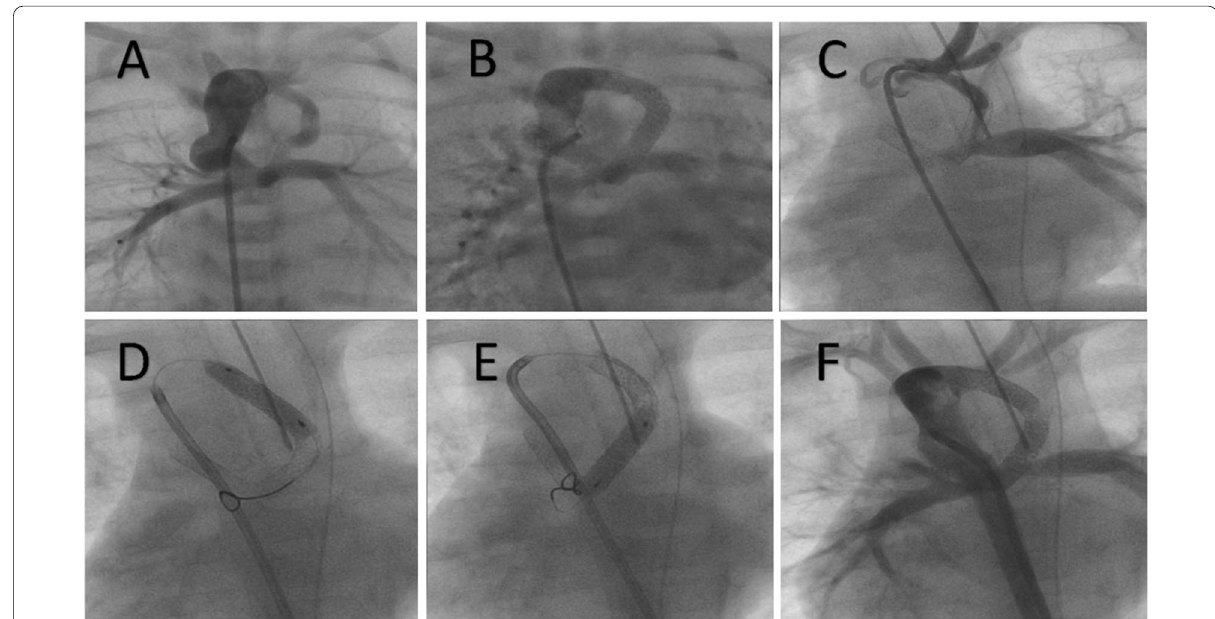
Fig. 3 In‑stent stenosis. This is a patient with tricuspid atresia/pulmonary atresia and double patent ductus arteriosus (PDA) ( A ), both stented due to severe confluence stenosis ( B ), presented a few months later with desaturation and in‑stent stenosis ( C ). Re‑stenting with 2 more stents ( D , E ) was done successfully ( F )